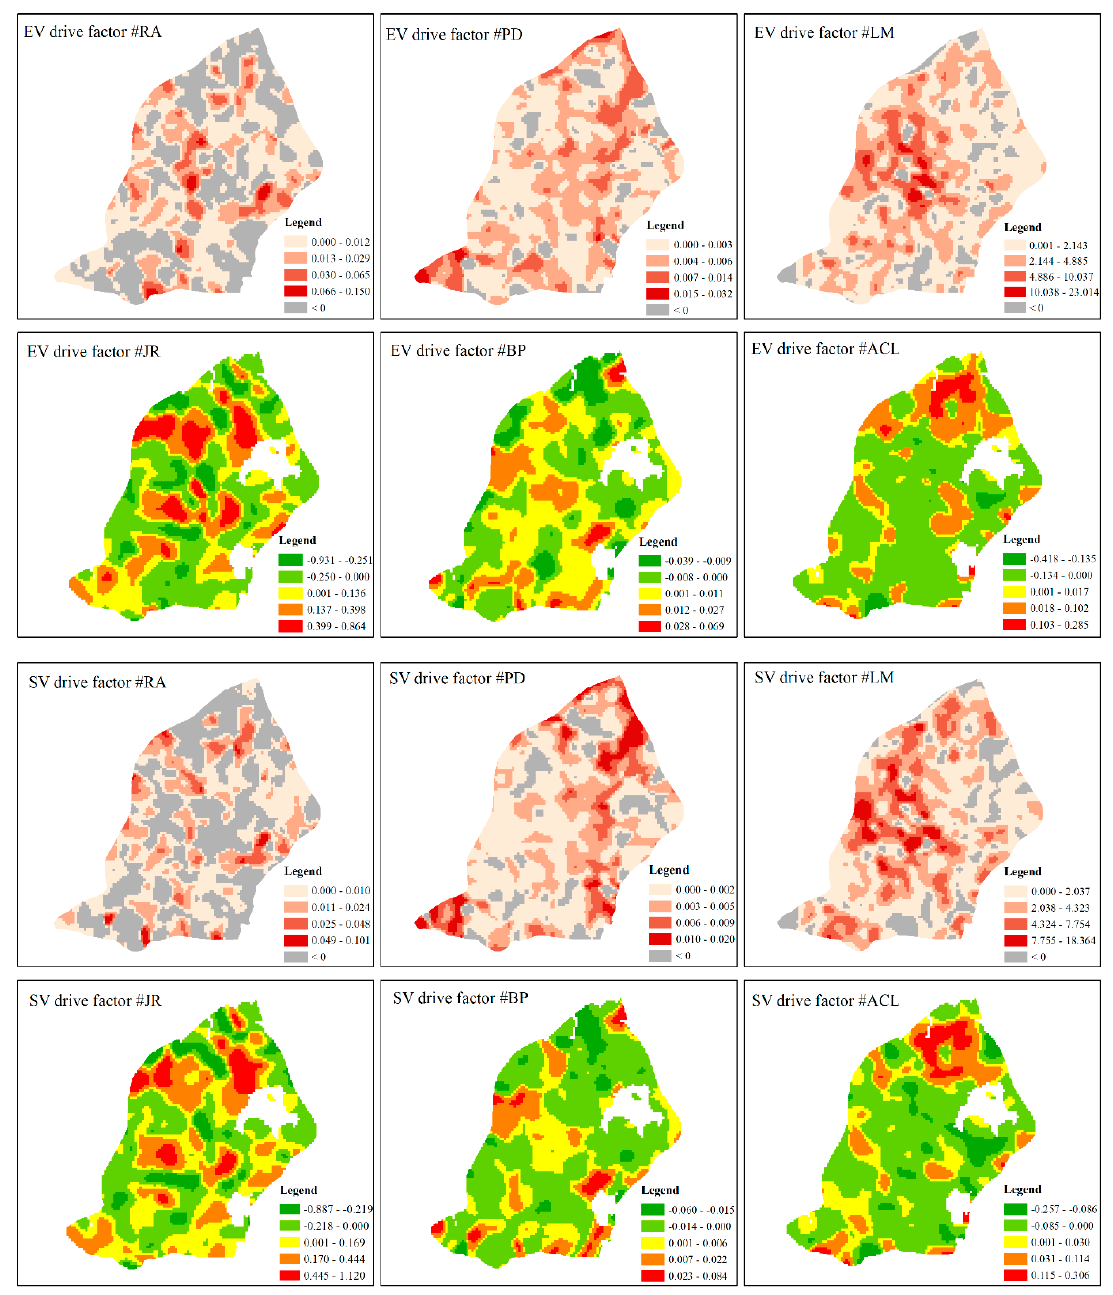
Figure 7. Spatial heterogeneity of various urban vitality driving factors. The first two lines are the spatial distribution of the coefficient of urban economic vitality (EV) driving indicators, and the following two lines are the spatial distribution of the coefficient of the urban social vitality (SV) driving indicators. The first and third lines express physical built dimension indicators, and the second and fourth lines reveal human–land interaction indicators. The darker red areas in the figures indicate that the urban vitality of the area is more affected by the explanatory variable, and the gray areas indicate that the influence relationship is not significant.